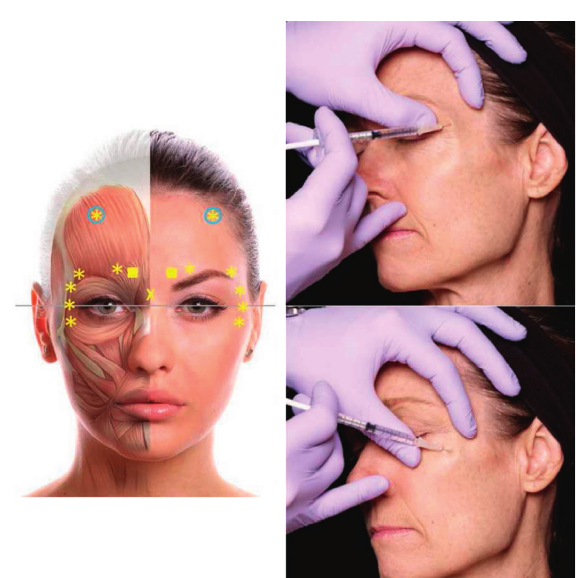
Figure 2: Botox was injected into five eyebrow areas and eight crow’s feet (four on each side) for eyebrow lift. The symbols represent different injection depths: the squares represent the full depth of the needle; X represents half needle depth; asterisk in- dicates one-third of the needle depth